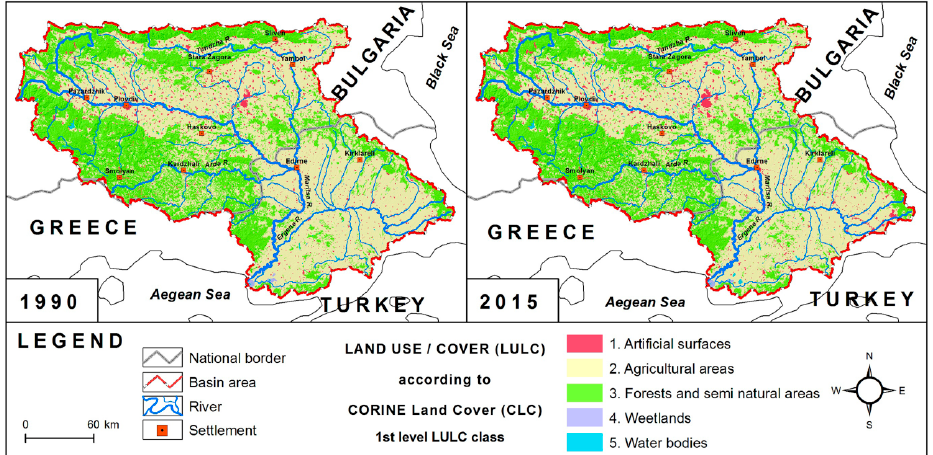
Figure 4. The map of LULC classes according to CORINE Land Cover (CLC).